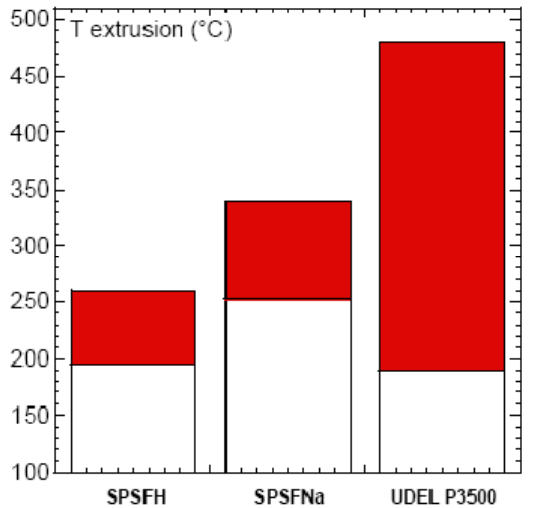
Figure 2. Extrusion temperature range for Udel sulfonated polysulfone in acidic and alkaline forms compared with pristine PSF (Udel P-3500).